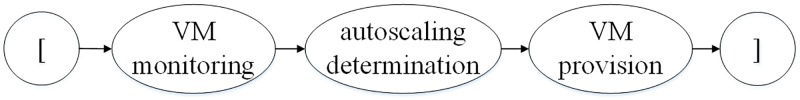
ESG of an elastic cloud management system.